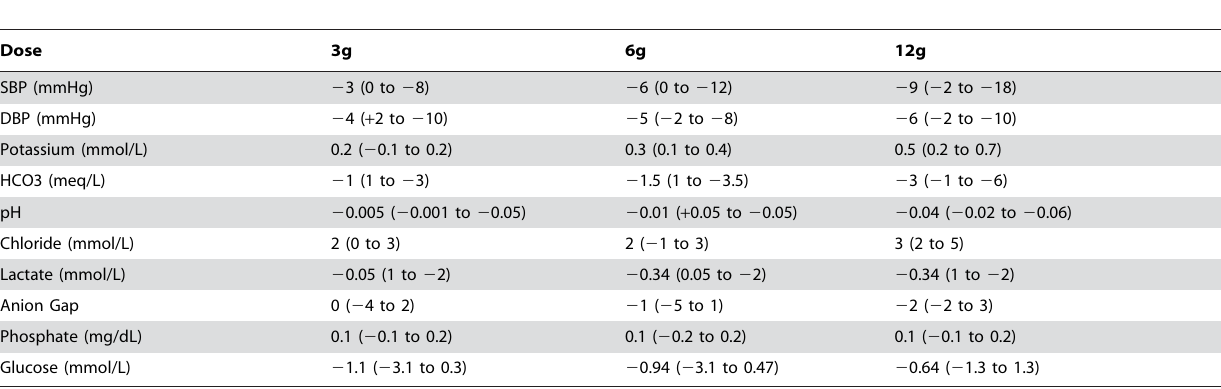
Table 2 . Maximum changes in parameters at any time during and for 2 hours after L-arginine infusion (3–12g) compared to pre infusion values (mean maximum change